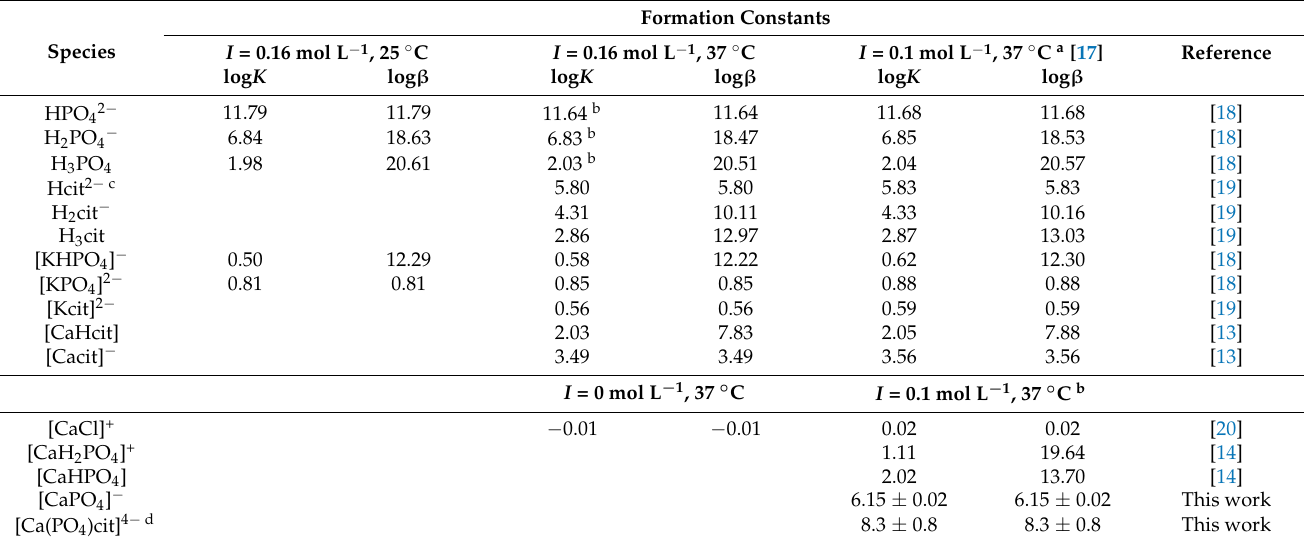
Figure 1. Titration curves recorded by both ISE-H + and ISE-Ca 2+ on a solution of Ca 2+ : 0.98 × 10 − 3 mol L − 1 ; K + : 1.00 × 10 − 1 mol L − 1 ; Cl − : 1.00 × 10 − 1 mol L − 1 ; PO 43 − : 2.35 × 10 − 3 mol L − 1 ; citrate: 1.00 × 10 − 3 mol L − 1 ; titrant: KOH 0.1 mol L − 1 ( I = 0.1 mol L − 1 ; t = 37 ◦ C). Full symbols: experimental points; empty black symbols—line: calculated values based on the speciation model reported in Table 1. Table 1. Overall (log β ) and partial (log K ) formation constants at 25 and 37 ◦ C, and at different ionic strengths, of the species in the water solutions containing Ca–phosphate and